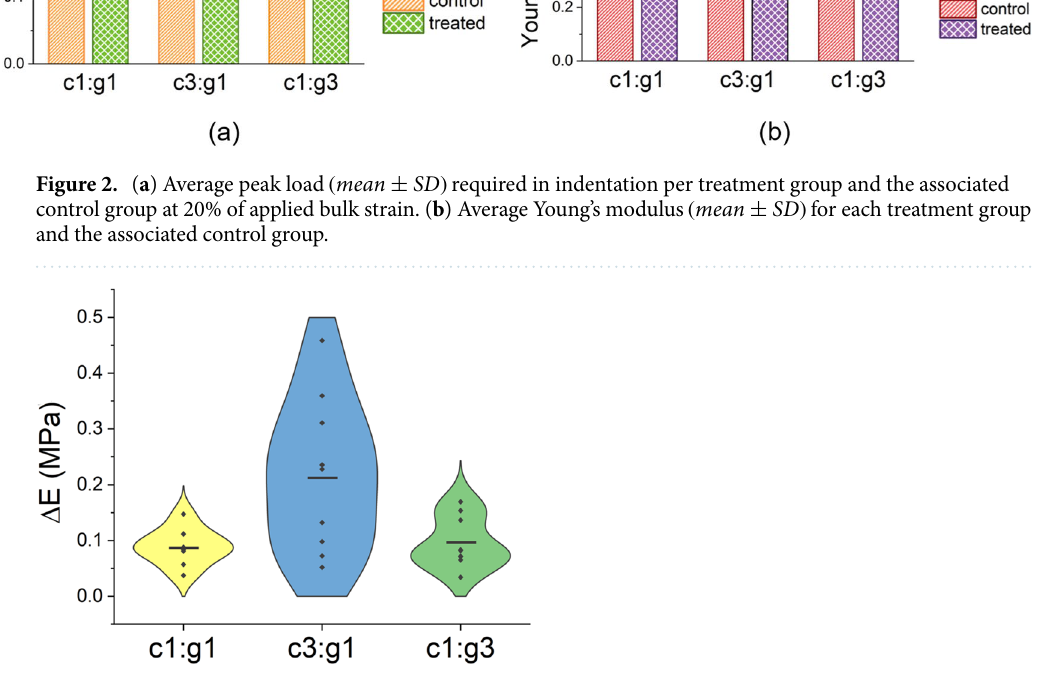
Figure 3. Distributions of changes in elastic modulus (� E ) of degraded cartilage for c1:g1, c3:g1, and c1:g3 treatments groups. The mean of each group is represented by a straight line. Individual data points within the distribution are